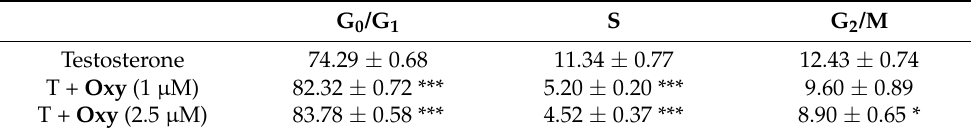
Table 1. Effects of Oxy on MCF-7aro cell cycle progression.